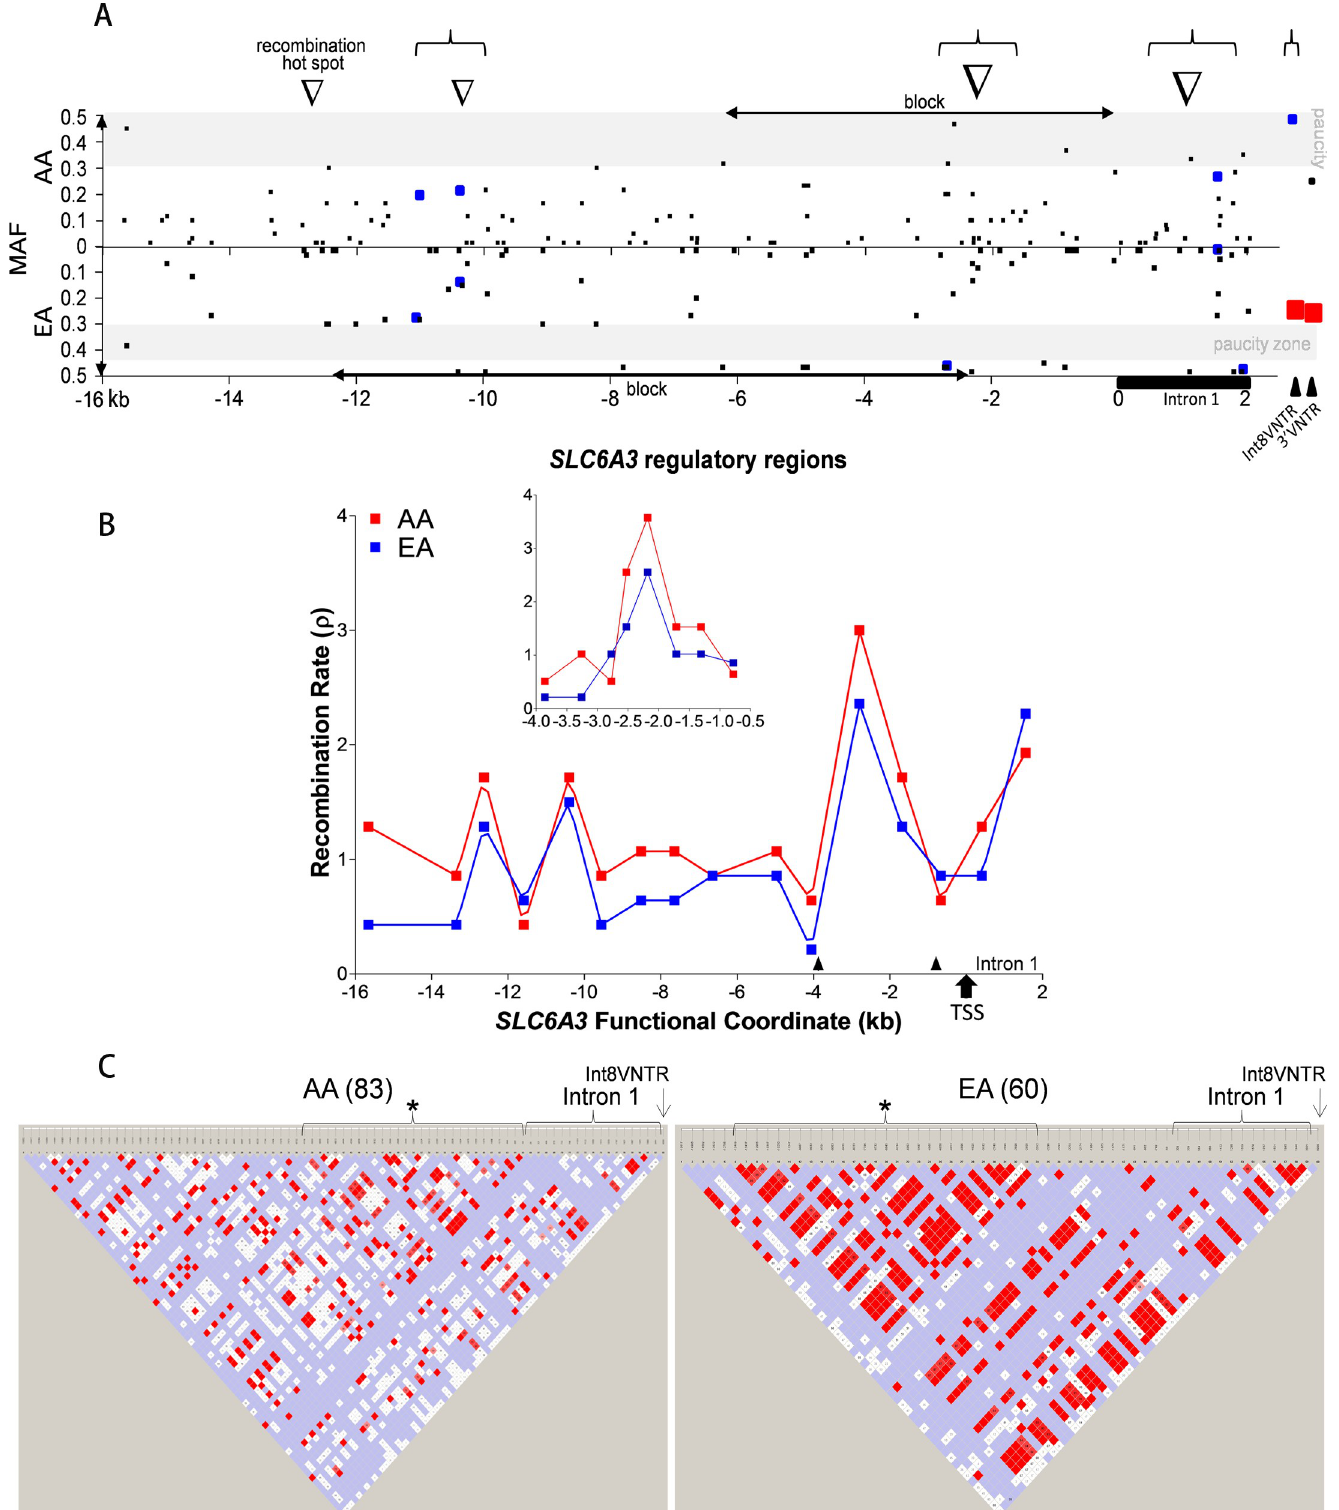
Fig 1. SLC6A3 regulatory region polymorphisms. (A) Asymmetric distribution of common polymorphisms between the AA ( upper panel ) and the EA ( lower panel ) cohorts. Each polymorphism is indicated by small black square. Gray areas indicate paucity of polymorphisms for indicated MAF range. Black horizontal bar, location